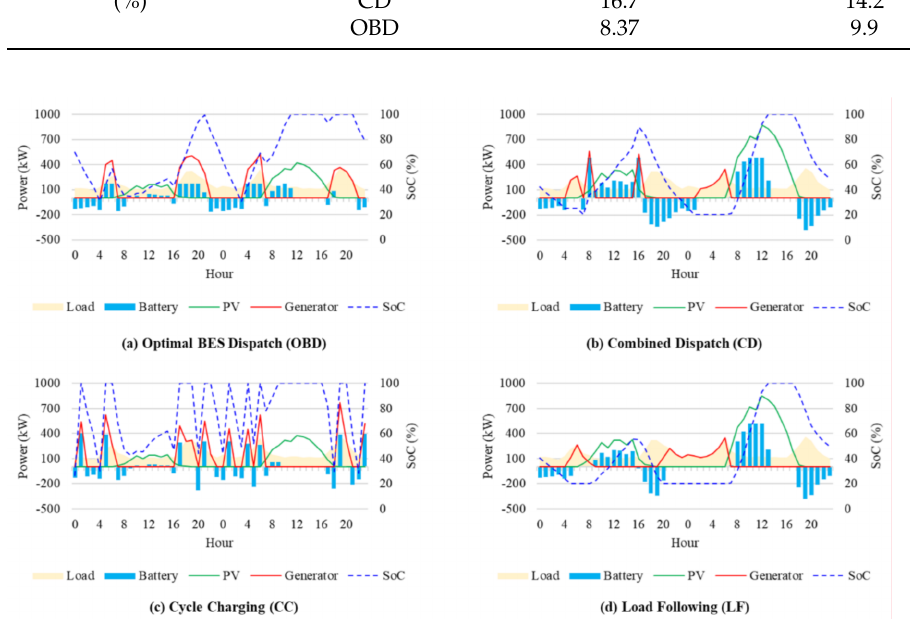
Figure 12. The operation pattern in System-1 for all control strategies in two consecutive days in March. BES was constantly discharged at the low load period, or every time there was a lack of supply from the PV